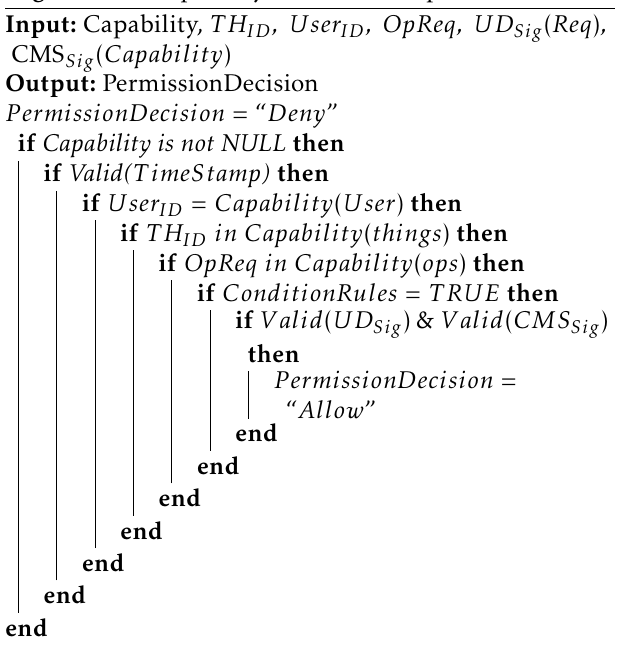
Algorithm 1 Capability authorisation